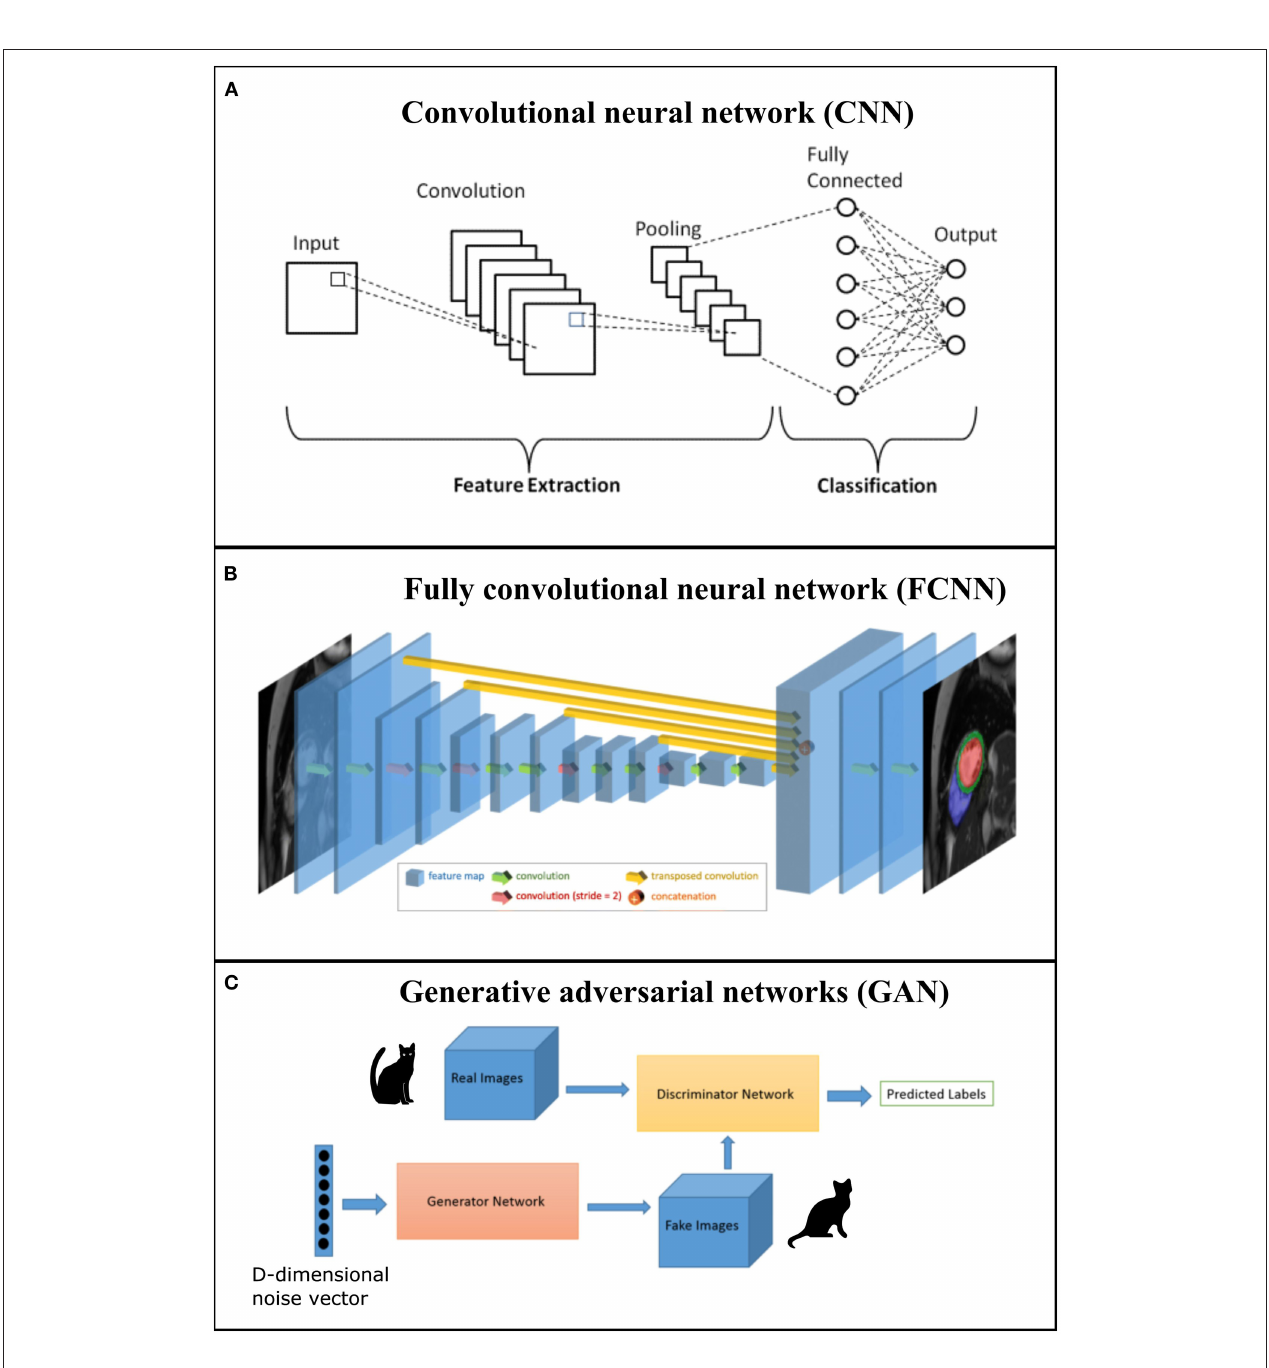
FIGURE 5 | (A) Example of a convolution neural network (CNN) where first section corresponds to the feature extraction and second section to classification; (B) Example of a generic fully convolutional neural network (FCNN) with feature map volumes that are color-coded by size. Figure adapted from Bai et al. (78); (C) Example of a generative adversarial networks (GAN) that comprises two networks (generator and discriminator).